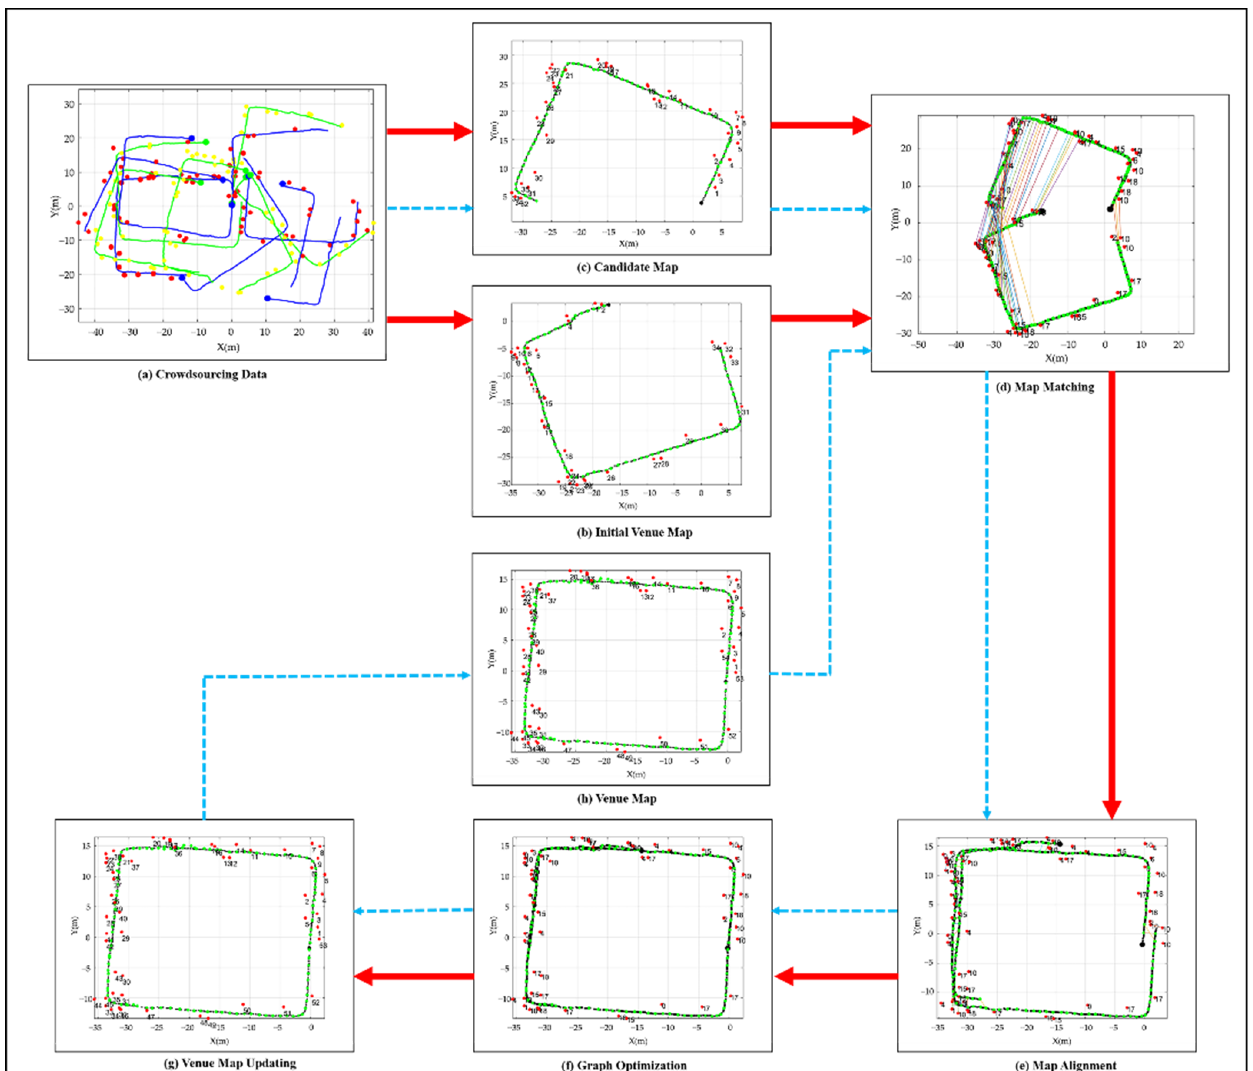
Figure 8. The process of venue map construction. The black circles denote the waypoints, red circles denote the semantic landmarks, and green circles denote the Wi-Fi landmarks.